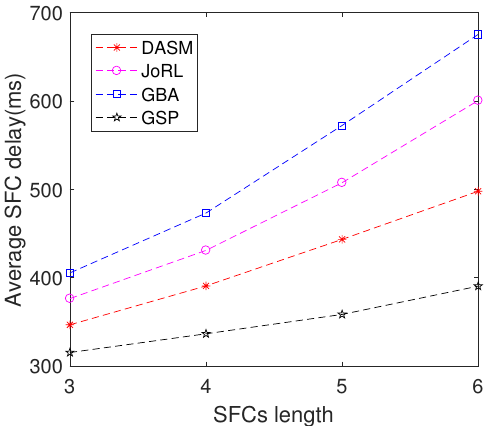
Figure 7. Average SFCs delay with the increasing SFCs